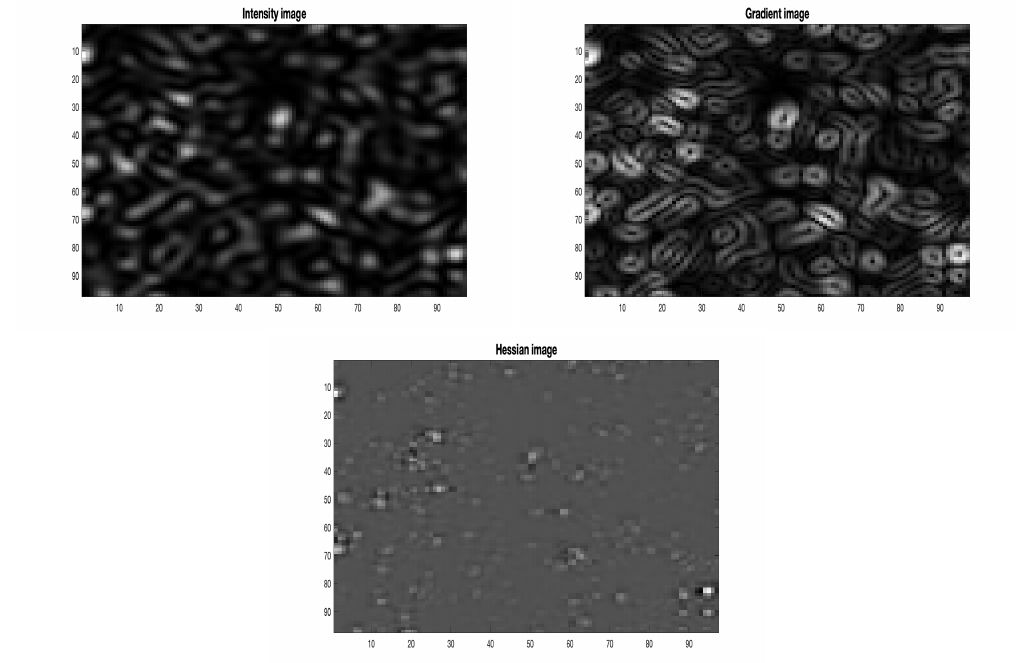
Figure 1. Images generated from the acquired set of intensity values. The upper left image shows the intensity distribution, the upper right image shows the magnitude of the calculated gradient vector, and the lower left image shows the determinant of the calculated Hessian